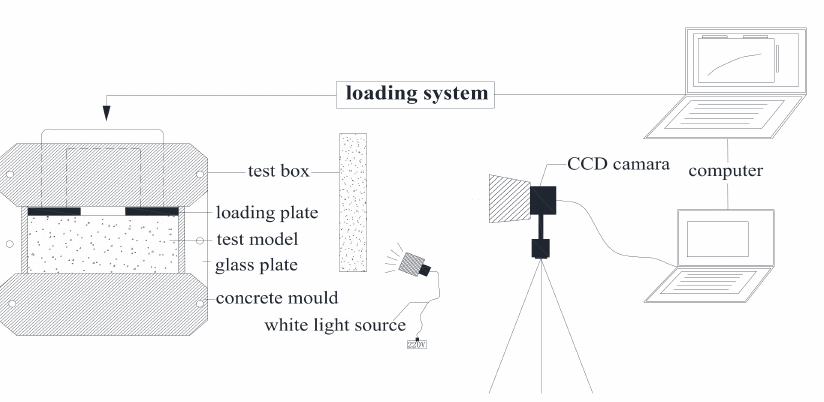
Figure 2. Sketch map of the deformation test